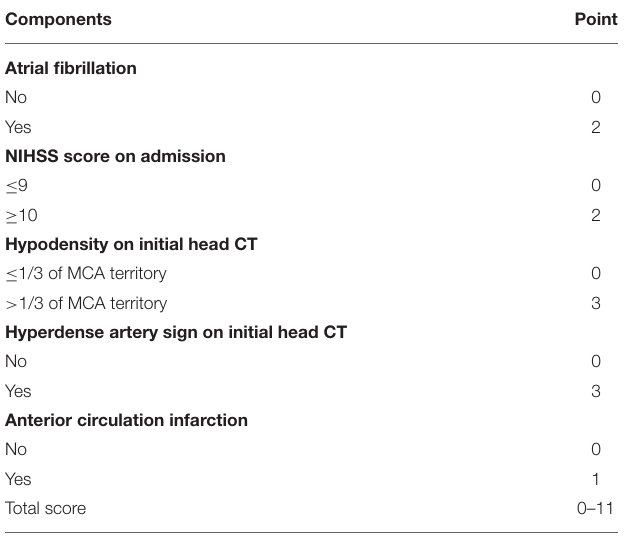
TABLE 4 | Score assignments of the predictive model of spontaneous hemorrhagic transformation. Components